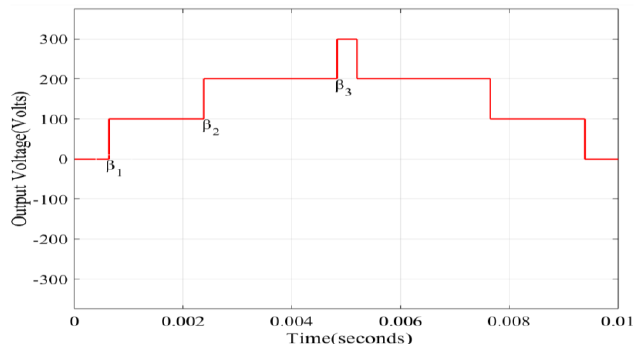
Figure 2. Output voltage half wave for the Quasi− linear seven level MLI.